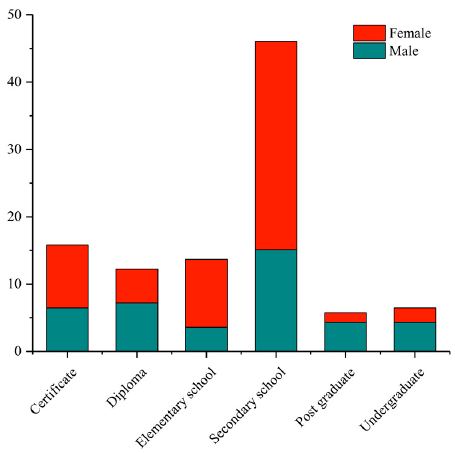
Figure 6. Education levels according to gender in the Nzhelele and Levuvhu river catchments.